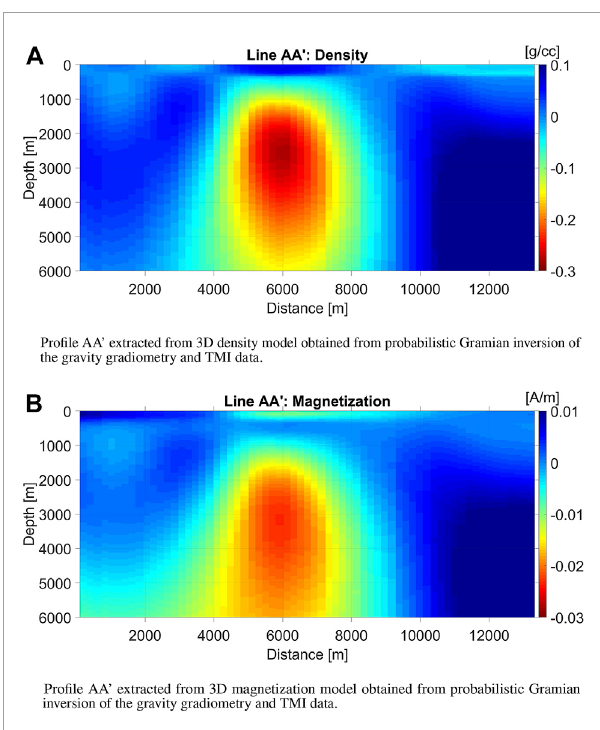
FIGURE 8 Probabilistic Gramian inversion results. (A) Profile AA’ extracted from 3D density model obtained from probabilistic Gramian inversion of the gravity gradiometry and TMI data. (B) Profile AA’ extracted from 3D magnetization model obtained from probabilistic Gramian inversion of the gravity gradiometry and TMI data.